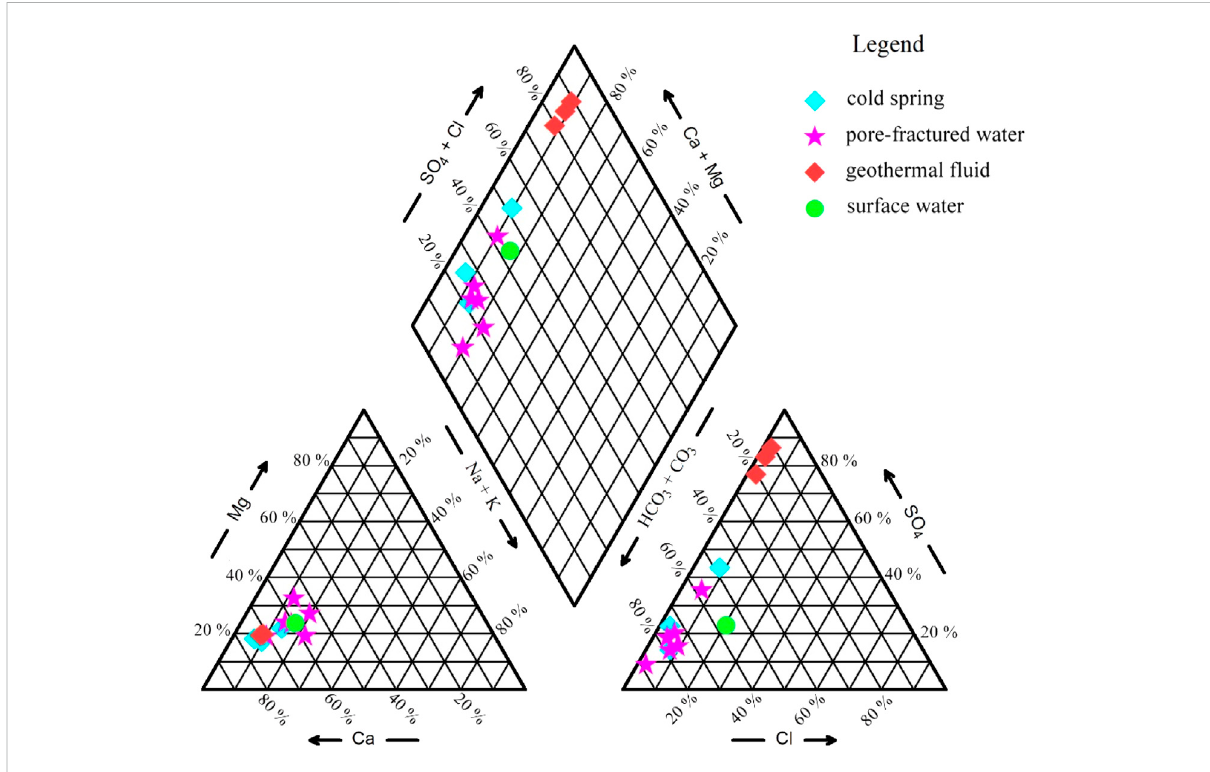
FIGURE 2 Piper three-line diagram of water chemical types.